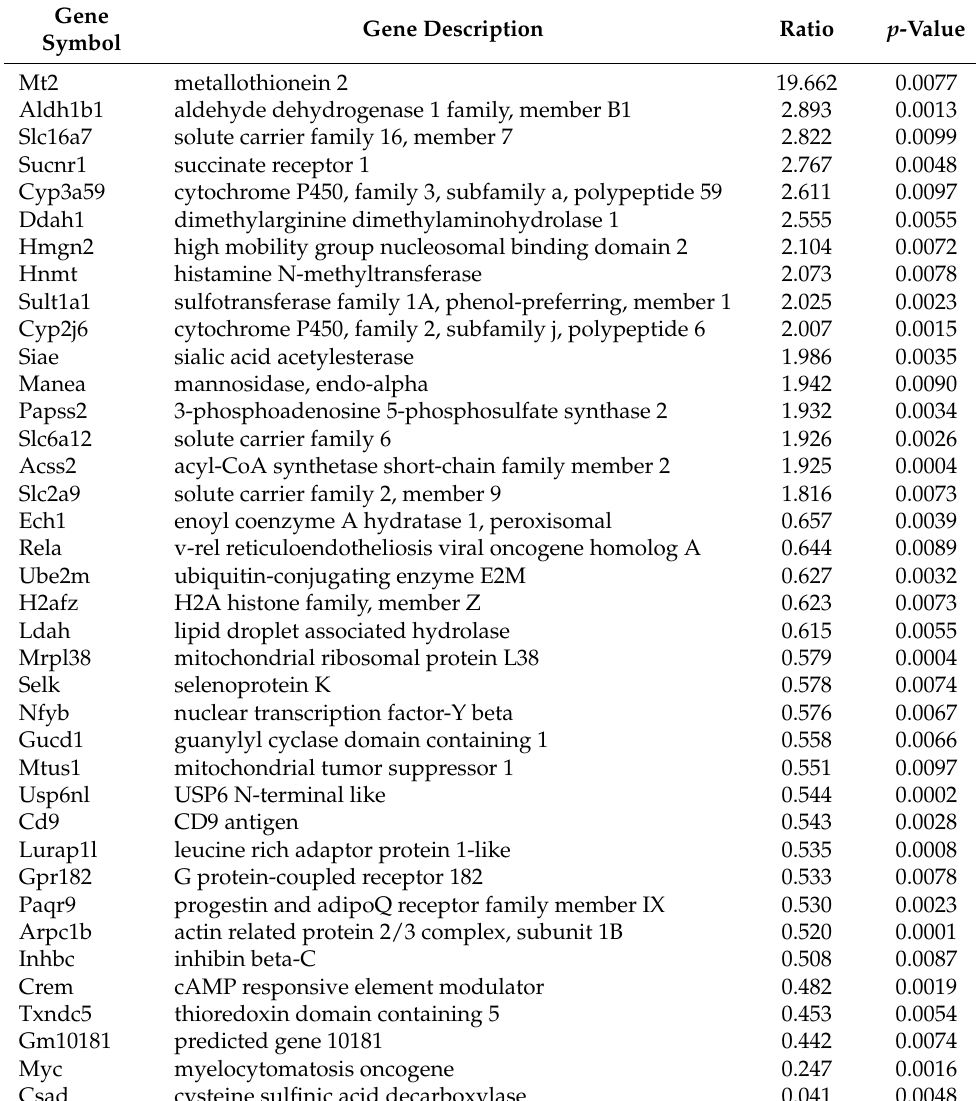
Table 1. Differential expressed genes in the liver of taurine-treated mice identified by microarray